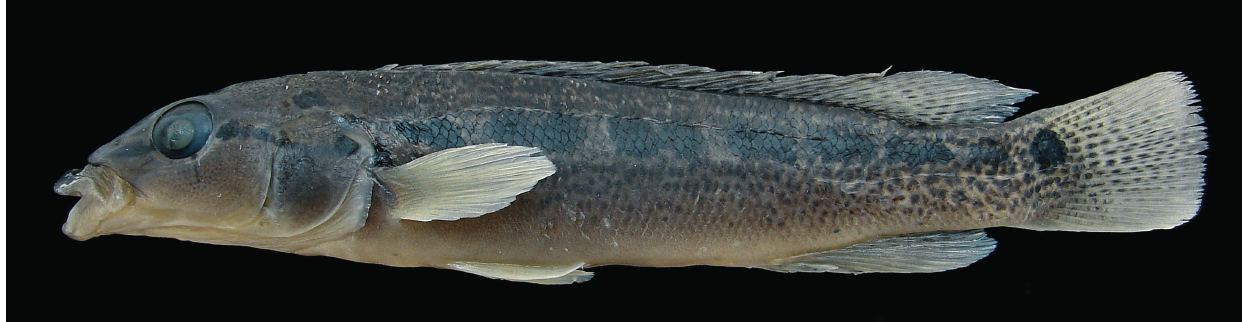
Fig. 6 . Crenicichla empheres , holotype, rio Chapecó, Abelardo Luz, Santa Catarina, MCP 40960 (104.4 mm SL, male).